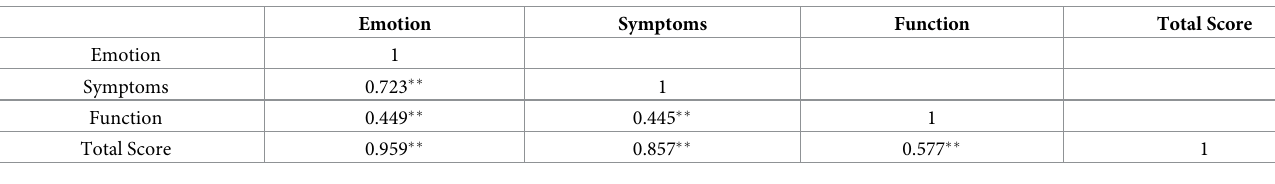
Table 6. Construct validity for the adjusted RosQol (n =